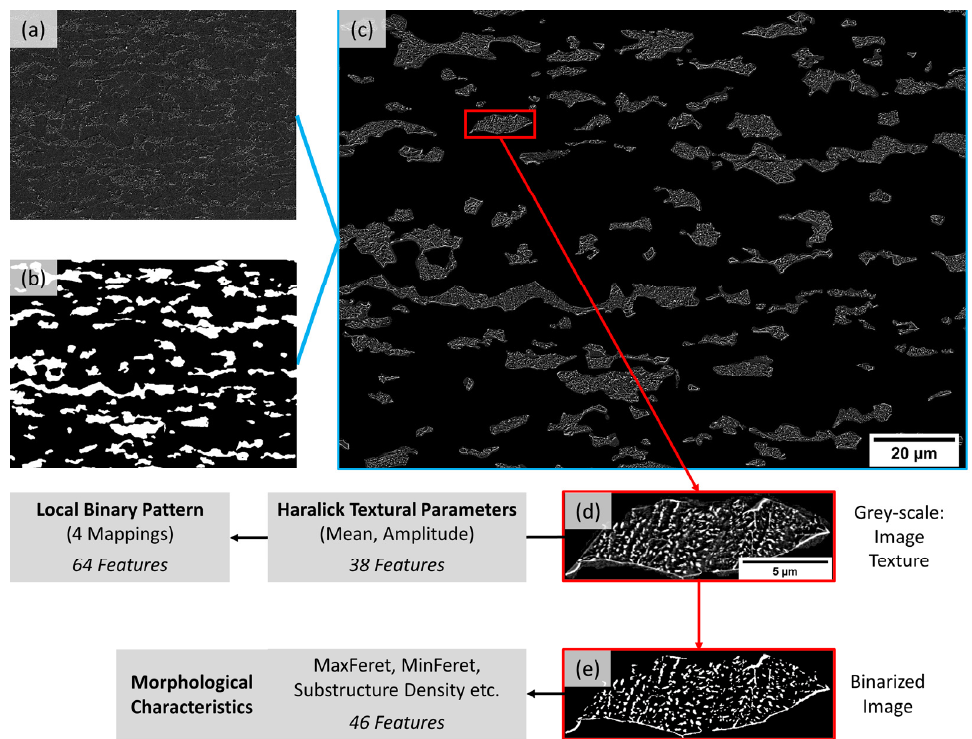
Figure 2. Different steps of object and feature extraction for microstructure classification. SEM ( a ) and segmented LM micrograph ( b ) are combined to remove ferritic matrix, define, and extract individual objects ( c ). SEM micrograph of an individual object is used to calculate textural features ( d ). Segmented SEM micrograph is used to compute morphological parameters ( e ).